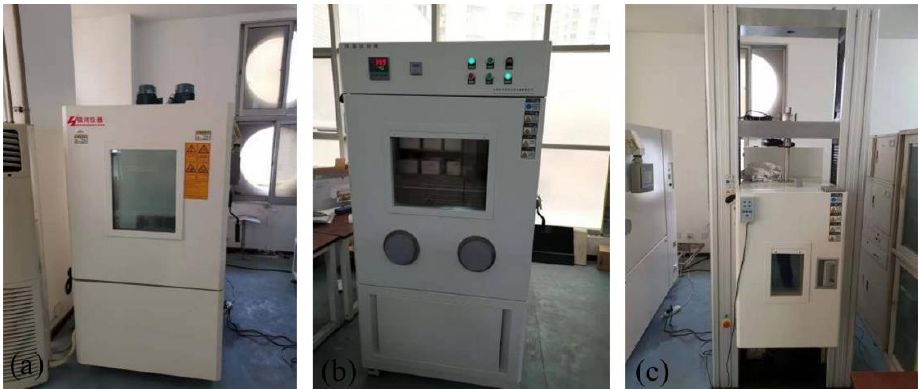
Figure 4. Environment chamber and universal testing machine. ( a ) Low-temperature environment test chamber. ( b ) Low-temperature operation test chamber. ( c ) Low-temperature electronic universal testing machine.